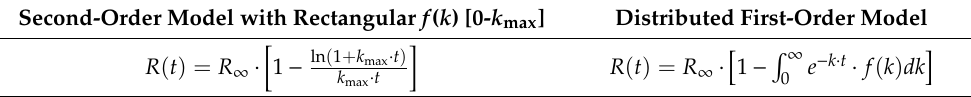
Table 4. Second-order model with Rectangular f ( k ) [0- k max ] versus its first-order representation. Second-Order Model with Rectangular f ( k ) [0- k max ] Distributed First-Order